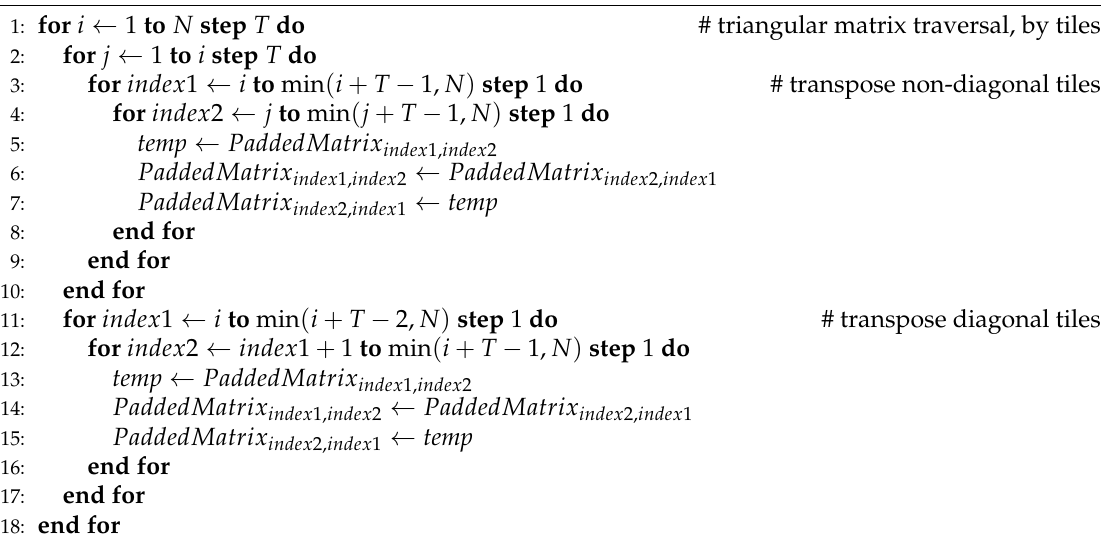
Algorithm 2 Tiling( PaddedMatrix , N , T ): Transposes a N row major order, through T